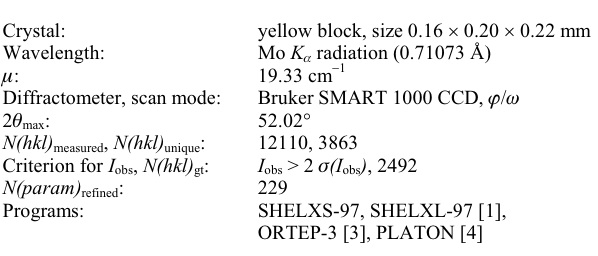
Table 1. Data collection and